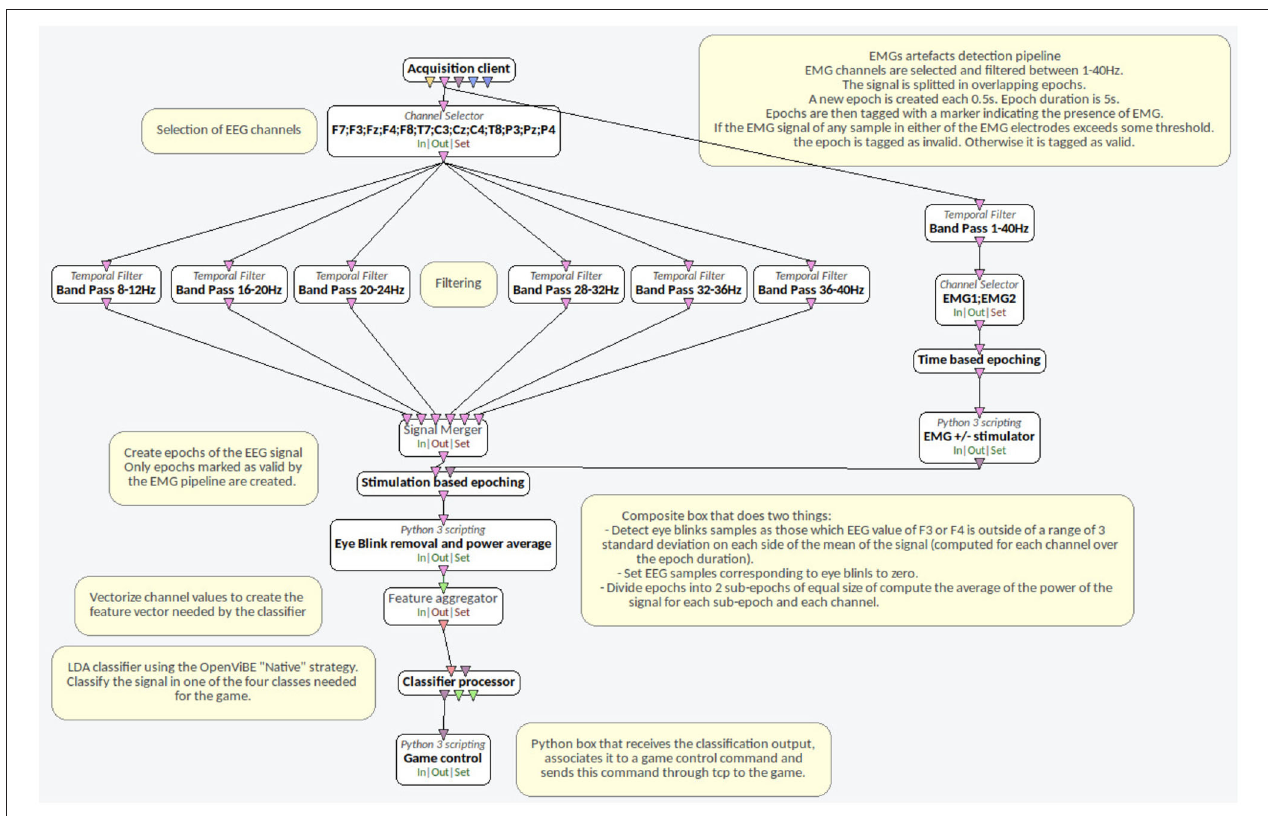
FIGURE 8 | Openvibe scenario developed to control the BCI